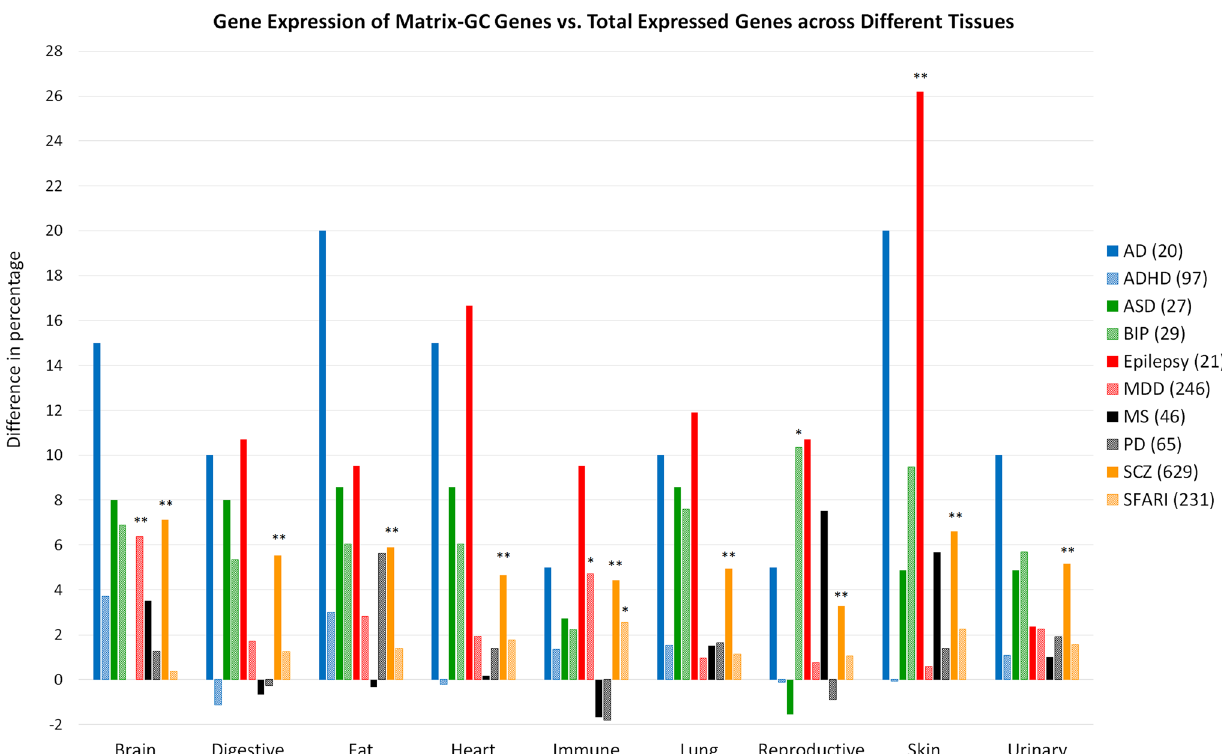
Figure 3. Genes associated to each disorder and tissue (horizontal axis) have a different RNA expression distribution (vertical, in percent) before and after Matrix-GC. Distribution of RNA expression, by tissue, for genes associated to brain disorders before and after Matrix-GC. The vertical axis reports the difference between the percentage of genes expressed in the different systems before and after Matrix-GC. Disorders included are Autism database (SFARI, Yellow), schizophrenia (SCZ, Orange), Parkinson’s disease (PD, Grey), multiple sclerosis (MS, Black), major depressive disorder (MDD, Pink), epilepsy (Red), autism (ASD, Dark Green), Alzheimer’s disease (AD, Blue), attention deficit hyperactivity disorder (ADHD, Light Blue) and bipolar disorder (BIP, Light Green). For immune, digestive, urinary and reproductive systems we considered data from different organs. Immune tissues include data from: lymph node, bone marrow, spleen, adrenal, thyroid and appendix data. Digestive includes data from: colon, duodenum, oesophagus, gall bladder, pancreas, liver, small intestine, salivary gland and stomach data. Reproductive tissues include data from: ovary, testis, endometrium, prostate and placenta. Urinary System urinary bladder and kidney data. Numbers in parentheses represent the total number of genes for which expression data was retrieved. The Fisher’s exact test was used for statistical calculations. *represents p value ≤ 0.05 and ** represents p value ≤